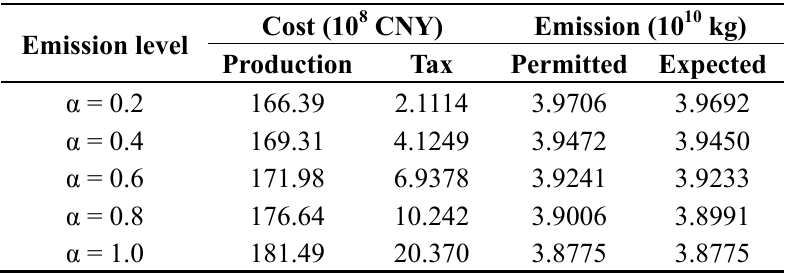
Table 5. Production cost and emission under different permitted emission level.